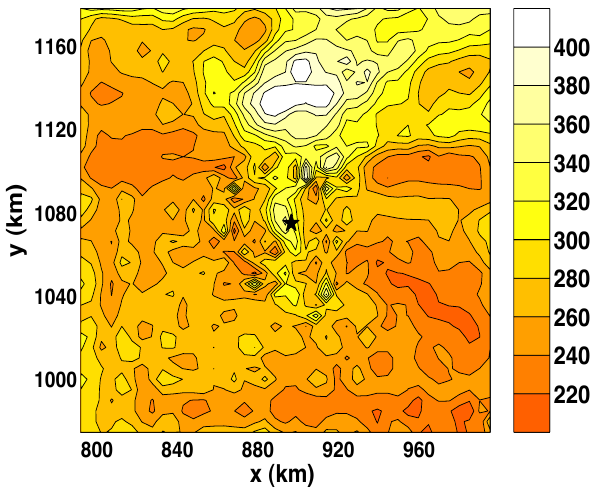
Fig. 13. Anisotropic steady-state simulation: Age at 95% depth (in ka, contour spacing 20 ka). The black star indicates the location of the Dome Fuji drill site, north is towards the top right (see Fig. 1).